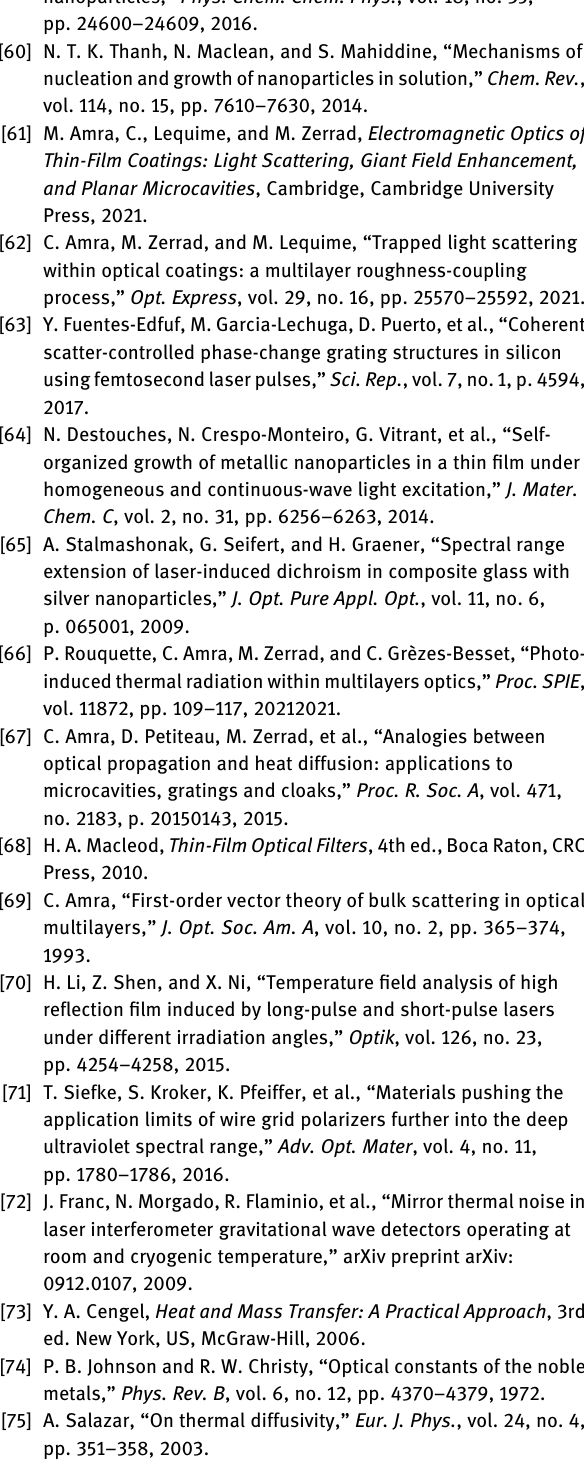
Supplementary Material: The online version of this article offers the supplementary material